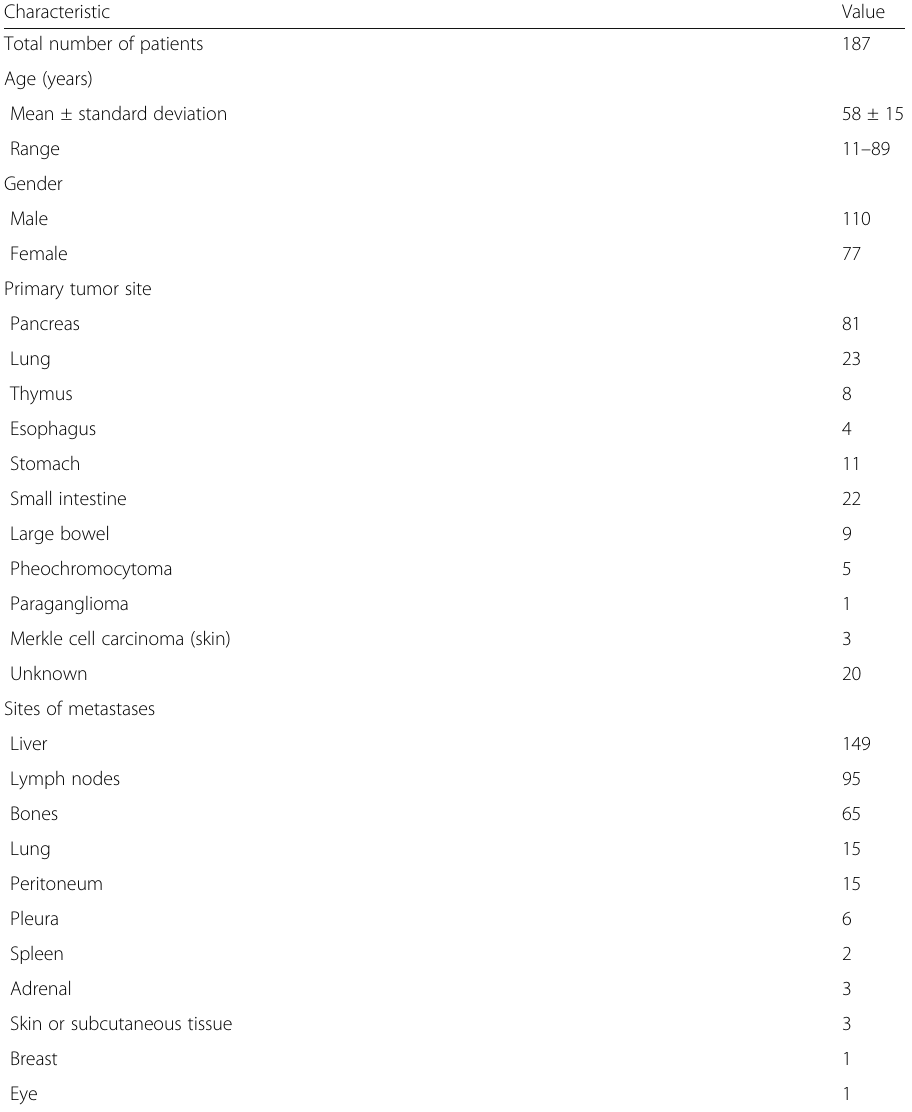
Table 1 Demographic data for the patients included in the study Characteristic Value Total number of